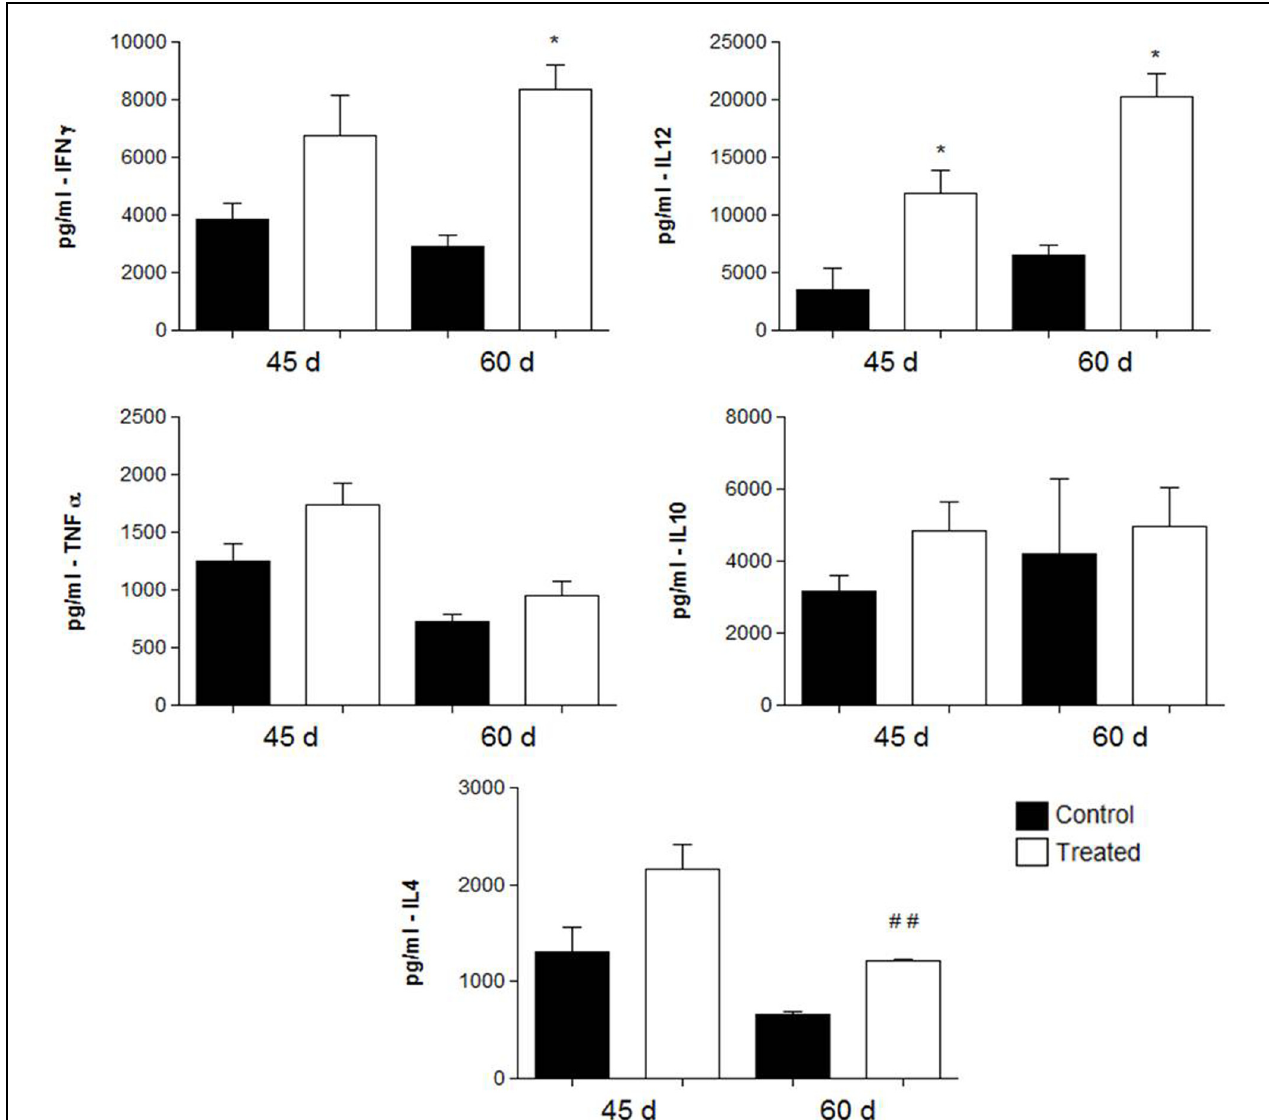
FIGURE 6 | Cytokine levels in the lungs obtained from BALB/c mice that received either 1 mg of polyclonal antibodies against acidic glycolipids or 1 mg anti- BSA polyclonal antibodies (control) 30 days after infection with Pb18 and sacrificed 45 and 60 days post-infection (therapeutic